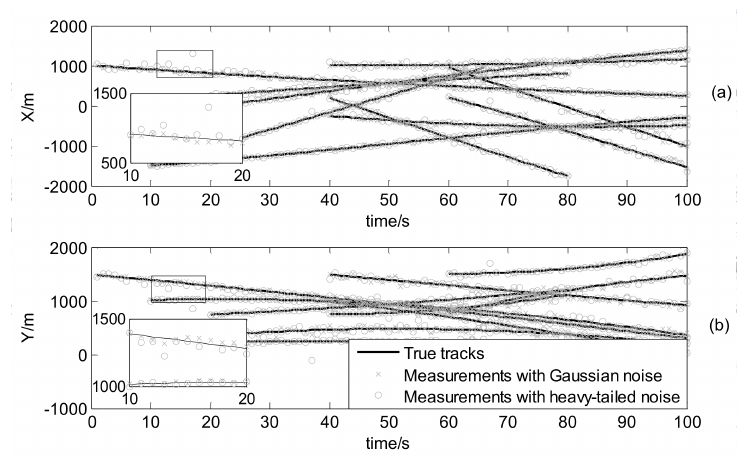
Figure 9. Measurements and true target positions versus time: ( a ) in x coordinate; ( b ) in y coordinate.